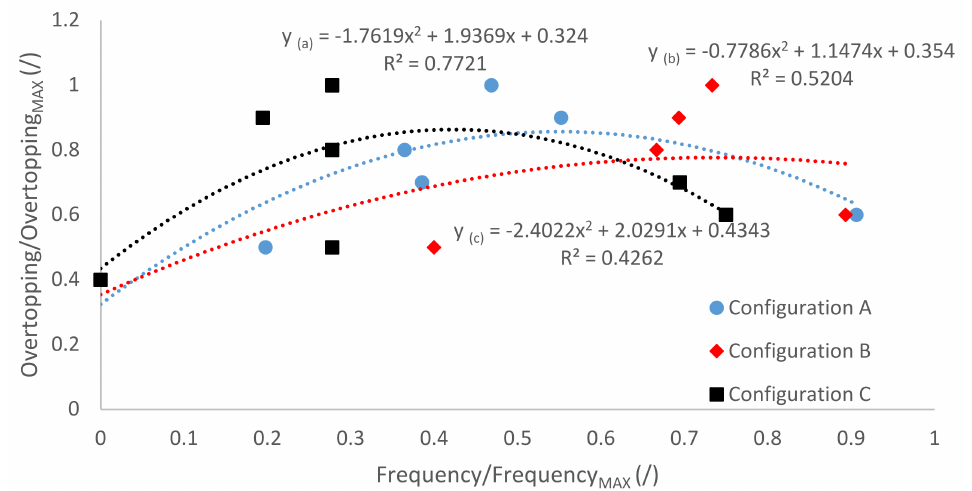
Figure6. Sinewavehydraulicconditions; relationshipbetweenwavecrestamplitudeAandovertopping volume Q (averaged results); no slope angle adopted within the experimental facility.